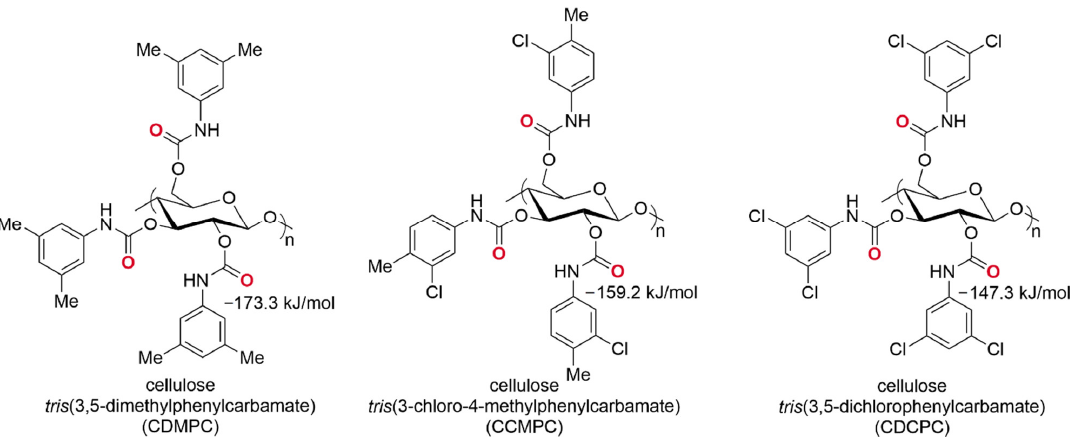
Figure 7. Structures of cellulose tris (3,5-dimethylphenylcarbamate) (CDMPC), cellulose tris (3- chloro-4-methylphenylcarbamate) (CCMPC) and tris (3,5-dichlorophenylcarbamate)